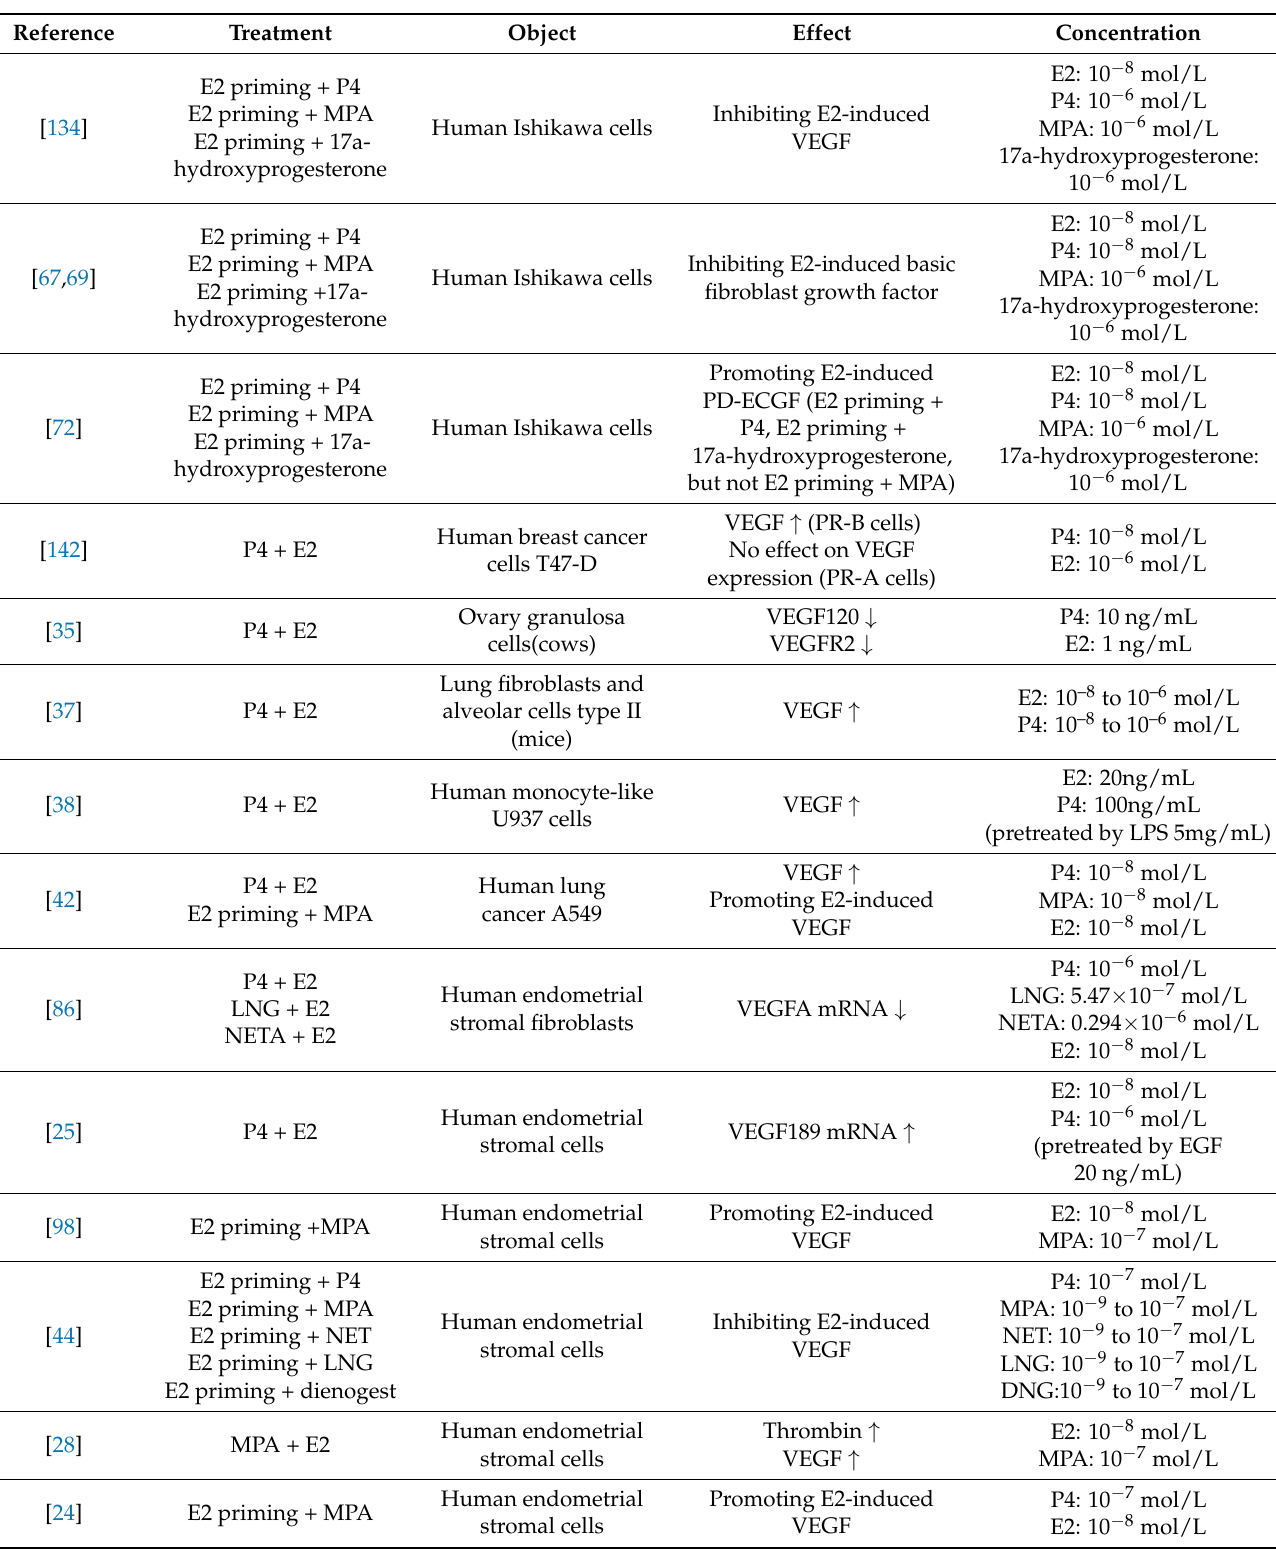
Table 3. The combined action of progestogens and E2; ↑ indicates a promoting effect; ↓ indicates an inhibitory